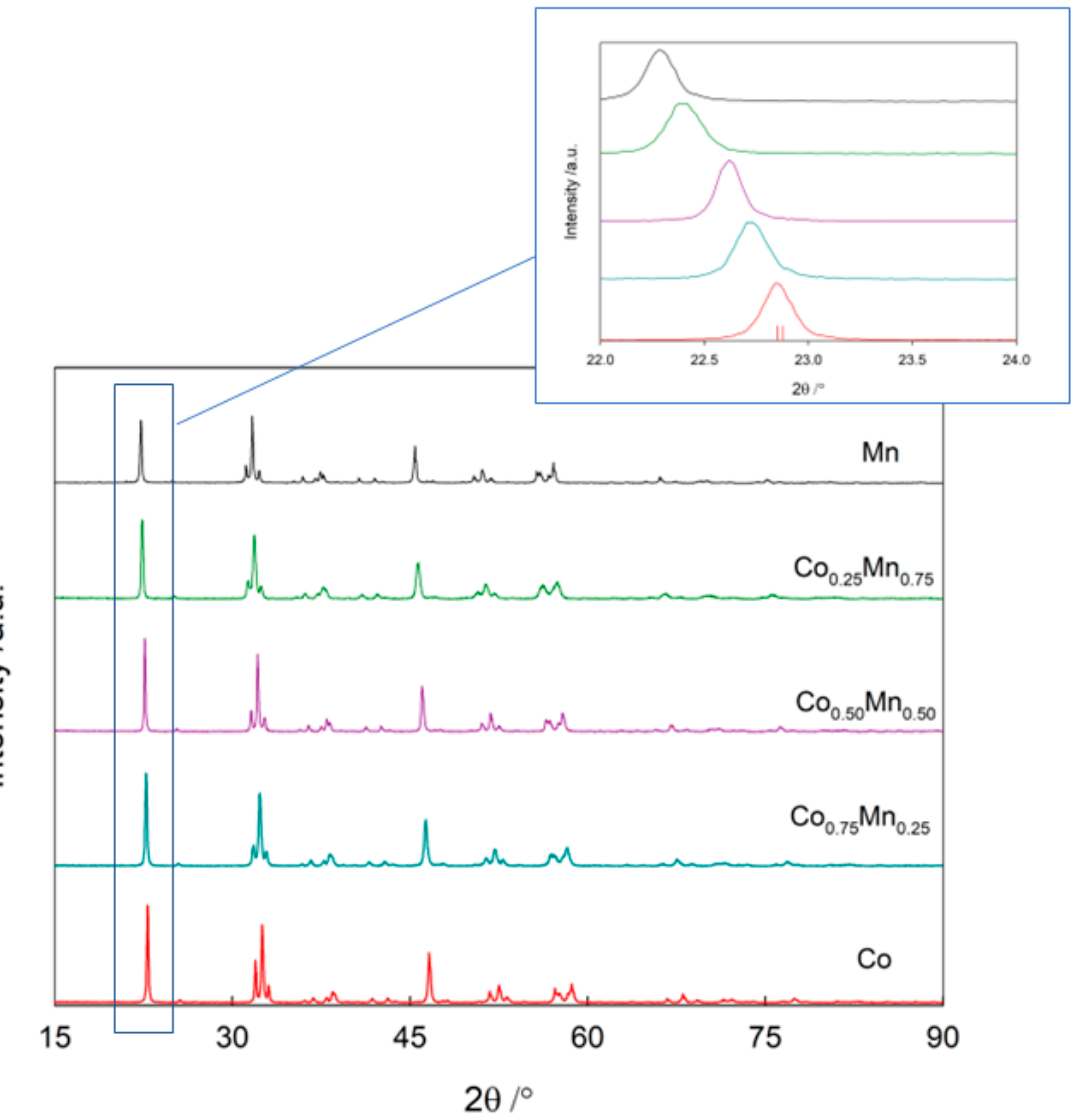
Figure 4. XRPD patterns of the NaCo 1-x Mn x F 3 series prepared without citric acid, highlighting the formation of a solid solution over the entire compositional range.